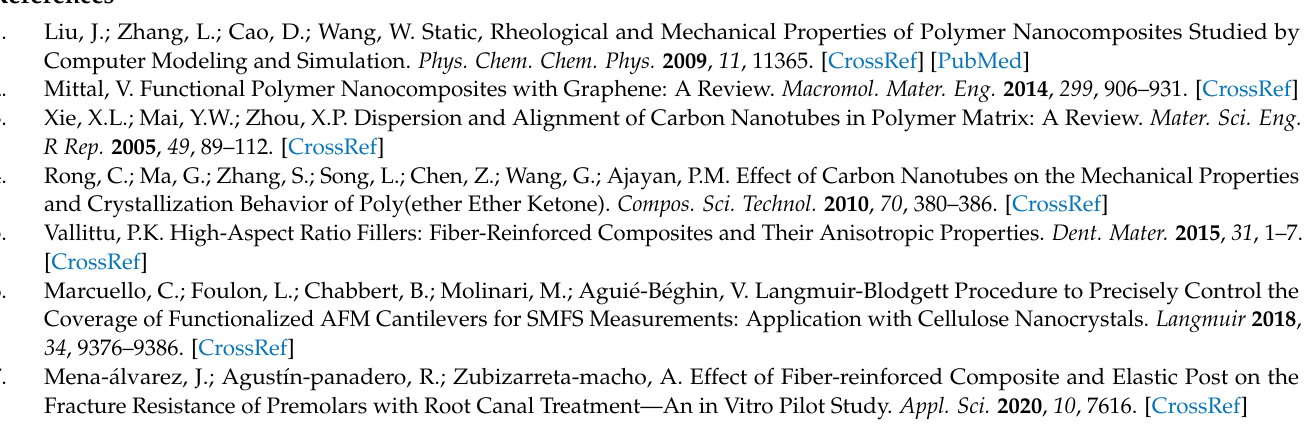
distance from the SWCNT axis. The results were obtained using computer simulations. The error bars are compared to the size of the symbols. Figure S5. The distribution of orientation angle θ of (a) DP and (b) PPI vectors directed along the planar moieties in PI R-BAPB-based nanocomposites with SWCNT after 9 µ s of computer simulation. The results were obtained using computer simu- lations. Figure S6. Temperature dependences of (a) elastic modulus G (cid:48) and (b) loss modulus G (cid:48)(cid:48) of R-BAPB samples ordered by SWCNT. We calculated the data along (||) ( XZ and YZ shear directions) and perpendicularly ( ⊥ ) (XY shear direction) to the SWCNT direction and an unfilled amorphous R-BAPB sample (averaged by three directions of shear deformation). The error bars are comparable to the symbol sizes. The rheological properties of amorphous unfilled R-BAPB samples were taken for comparison with a previous study. The results were calculated using computer simulations. The error bars are compared to the size of the symbols. Figure S7. Temperature dependences of the elastic modulus G (cid:48) of amorphous unfilled and R-BAPB samples oriented by SWCNT. The error bars are comparable to the symbol sizes. The rheological properties of the unfilled amorphous R-BAPB samples were taken for comparison from a previous study. We calculated the results using computer simulations. The error bars are compared to the size of the